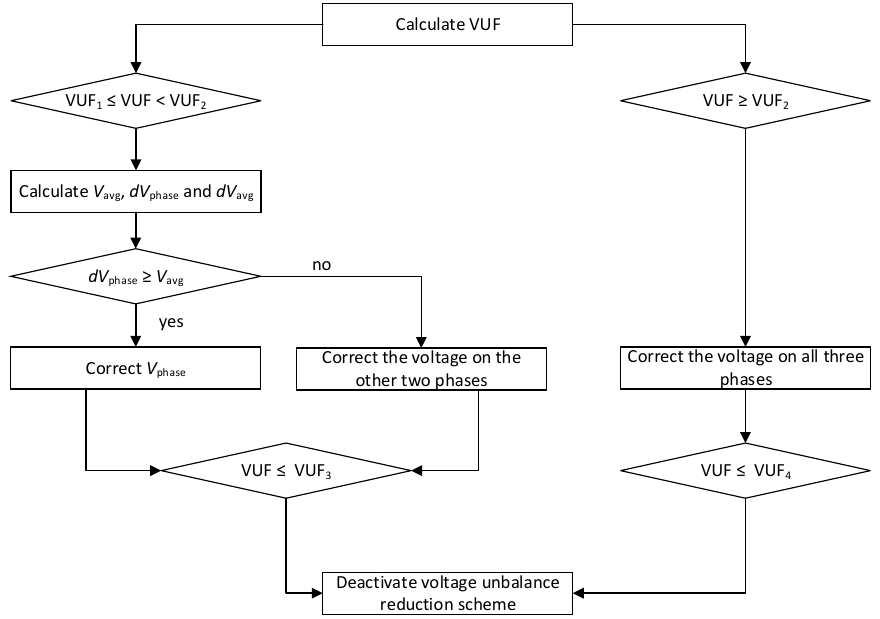
Figure 3. Flowchart of the proposed voltage unbalance reduction